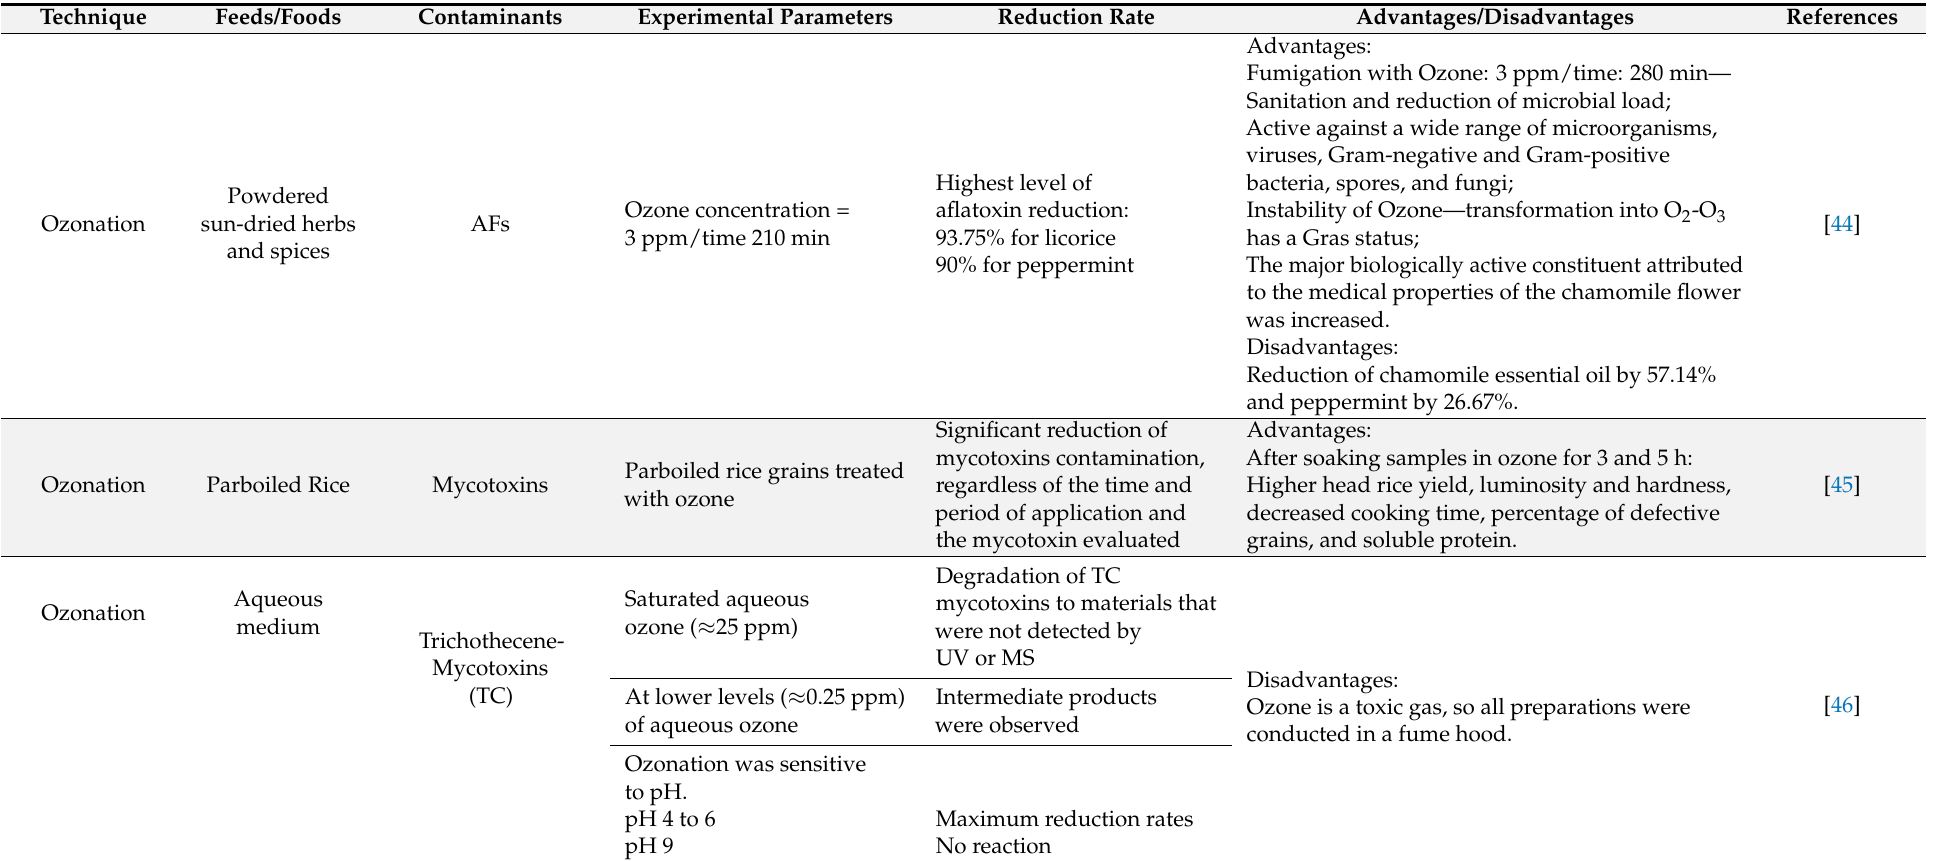
Table 1. Chemical treatments for the reduction of mycotoxins in solid foods and